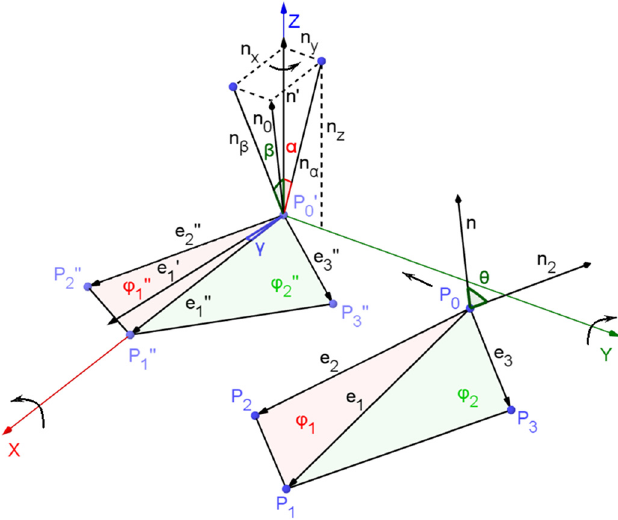
Fig. 10. Coordinate transformation of two arbitrary polyhedron faces ’ 1 , ’ 2 with the common edge e